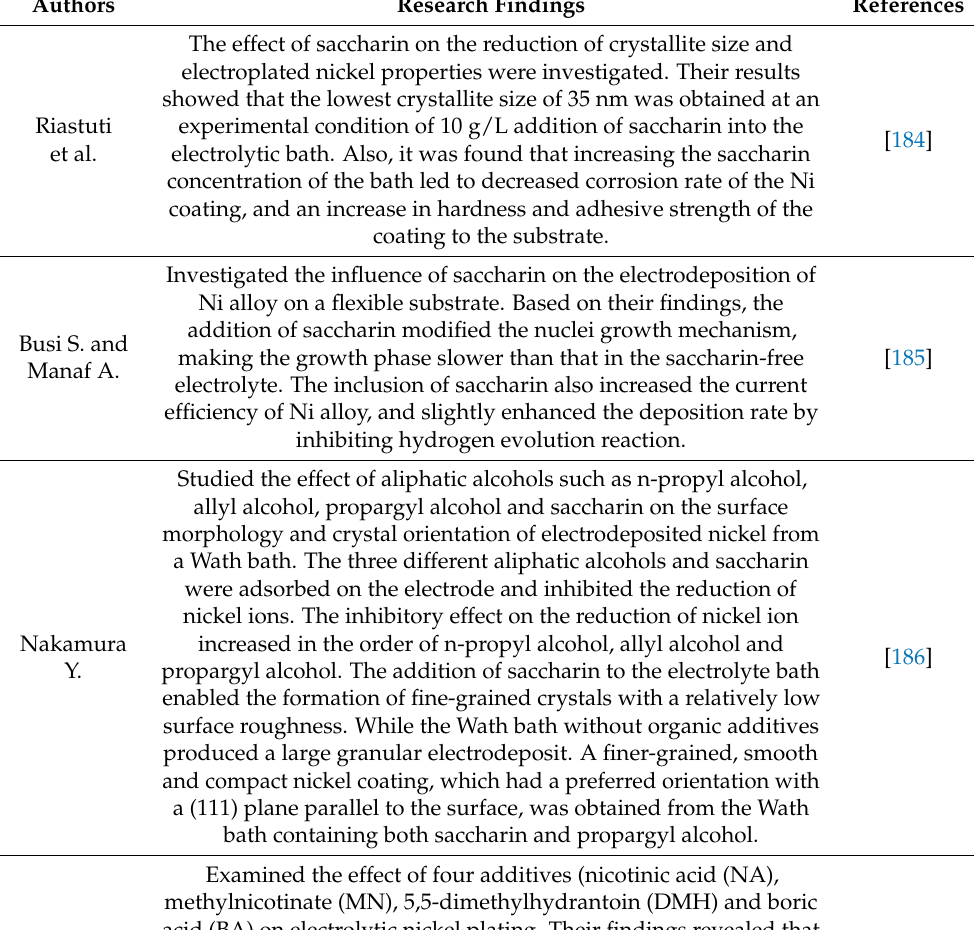
Table 1. A summary of previous studies showing the effects of additives on electrodeposited Ni